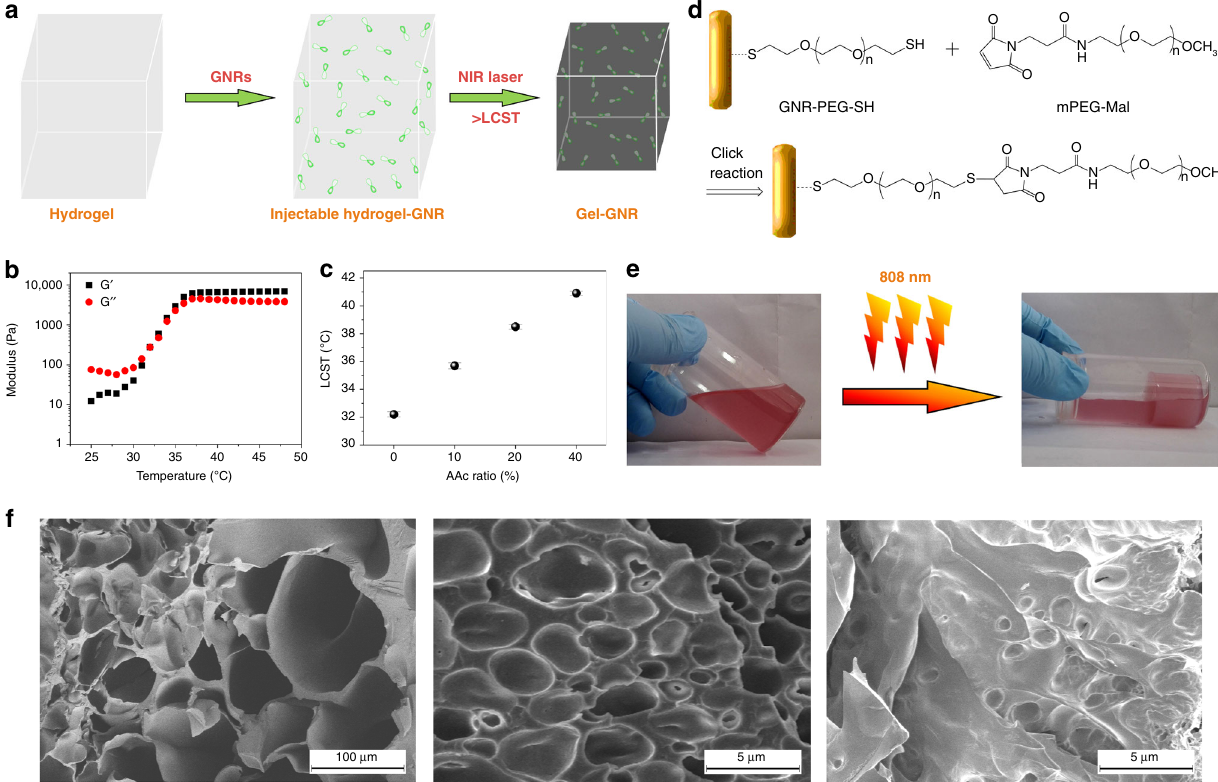
Fig. 1 Synthesis and characterizations of hydrogel – GNR. a Schematic on the gelation process of hydrogel – GNR. b Temperature-dependent rheological curves of pNIPAAm without AAc segment, wherein the crossover between G ′ and G ′′ that represent storage modulus and loss modulus, respectively, is determined as the gelation temperature (that is, LCST). c LCST of pNIPAAm- co -AAc with tunable AAc content (0%, 10%, 20%, and 40%) determined by dynamic oscillatory temperature sweeps, and data are expressed as mean ± standard deviation (SD) ( n = 3). d Schematic of chelation reaction between GNR-PEG-SH and mPEG-Mal in CS/mPEG-Mal/pNIPAAm- co -AAc. e Digital photos of hydrogel – GNR (50 ppm) before and after 808 nm irradiation,